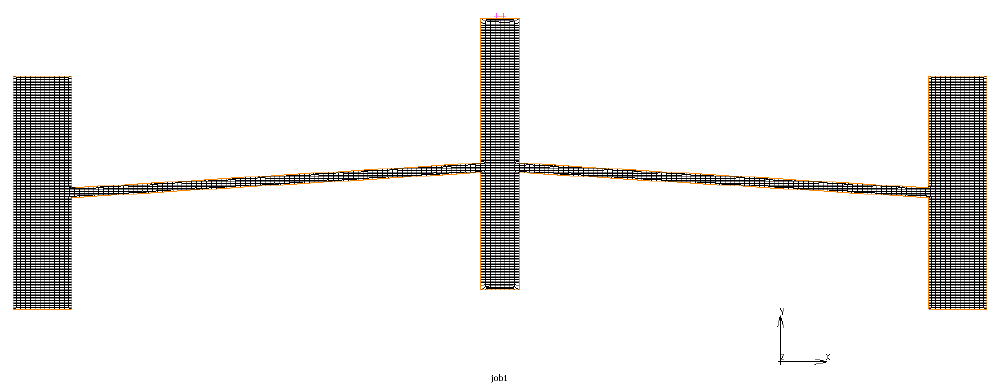
Figure 5. FEM model of the 2-beam V-type actuator.